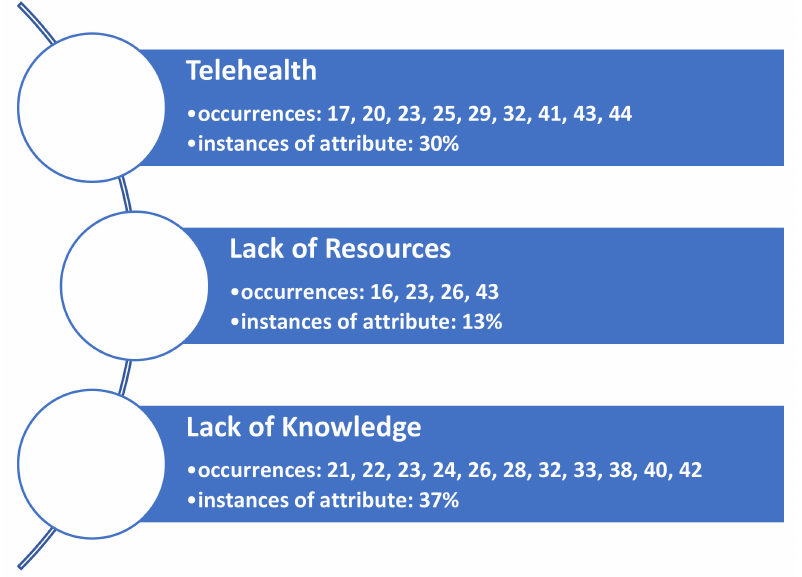
Figure 3. Themes (constructs) identified as barriers leading to a decrease in patient throughput in ambulatory care organizations during